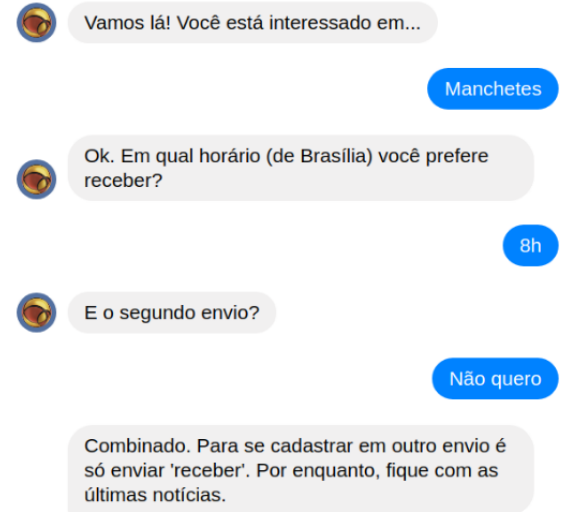
Fig. 21. Follow-up on the suggestions on the UOL Not´ıcias chatbot. Translation: –Let’s go! You are interested in... –Headlines –Ok. At what time (Brasilia time zone) do you want to receive it?